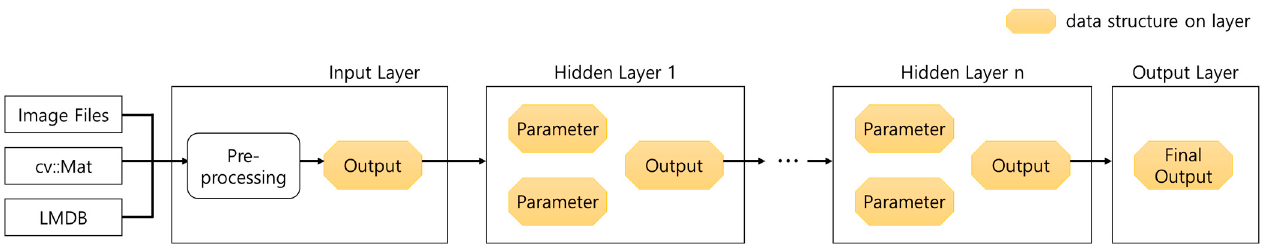
Figure 4. Structure diagram of the layer structure linked to the data